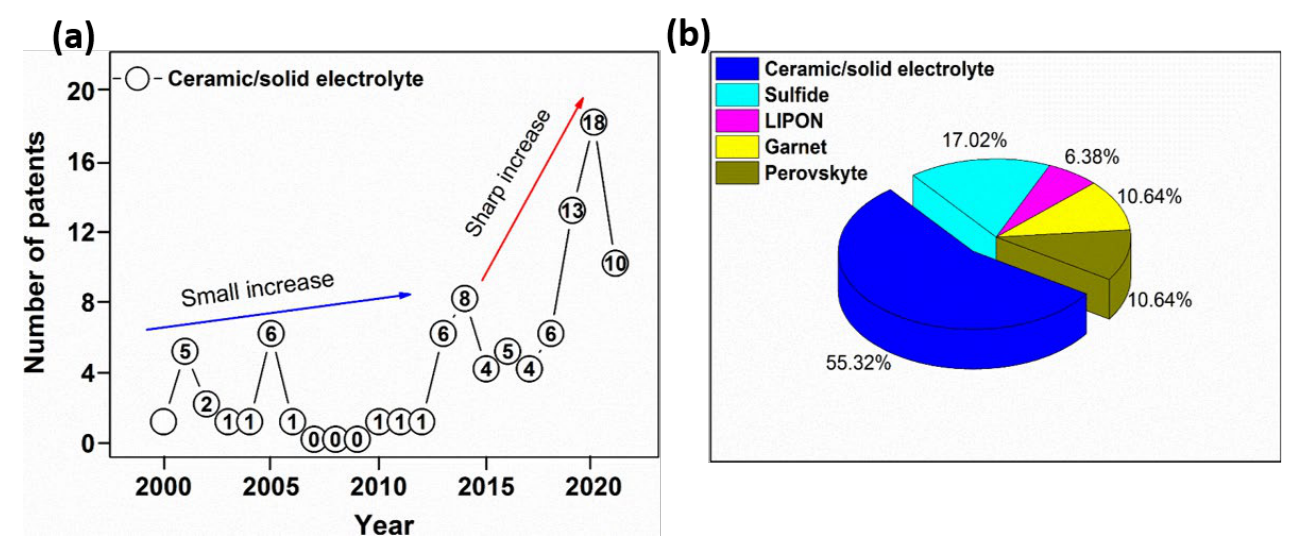
Figure 7. Overview of patents for ceramic/solid electrolytes during 2000–2020.